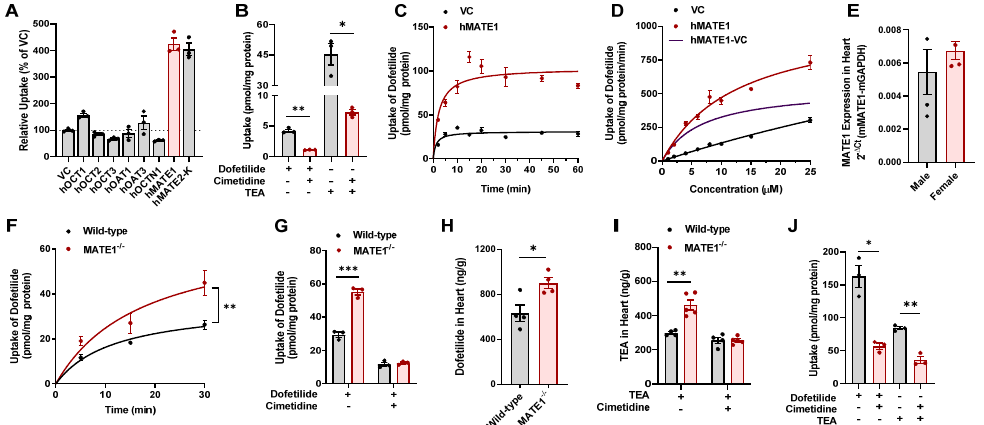
Figure 1. Inhibition of MATE1 enhances cardiac accumulation of dofetilide. ( A ) Transport of [ 3 H] dofetilide (1 µ M, 15 min) in cells overexpressing the human transporters OCT1, OCT2, OCT3, OAT1, OAT3, OCTN1, MATE1, or MATE2-K (2 min). Relative uptake is expressed as percentage change compared with empty vector controls (n = 3). ( B ) Relative uptake of [ 3 H] dofetilide and [ 14 C] TEA in HEK293 cells overexpressing human MATE1 in the presence and absence of cimetidine (25 µ M). ( C ) Time dependent uptake (2–60 min) of [ 3 H] dofetilide (1 µ M) in HEK293 cells stably transfected with vector control (VC) or MATE1. ( D ) Transport kinetics of [ 3 H] dofetilide in cells overexpressing human MATE1. The Michaelis-Menten constant (K m ) and the maximal uptake rate (V max ) values for the kinetics of dofetilide (1–25 µ M) was determined after an incubation time of 2 min. K m and V max values for transport activity are 6.72 ± 1.71 µ M, and 544.40 ± 55.70 pmol/min/mg, respectively. ( E ) Expression of the MATE1 gene in hearts isolated from untreated wild-type male and female mice (n = 4 per group). ( F ) Time dependent uptake of [ 3 H] dofetilide (2 µ M) in ex vivo cardiomyocytes isolated from wild-type or MATE1-deficient female mice (n = 4–6 per group). ( G ) Ex vivo concentrations of [ 3 H] dofetilide (2 µ M) in cardiomyocytes isolated from wild-type or MATE1-deficient female mice (n = 3 per group) for 30 min in the presence or absence of cimetidine (25 µ M) pretreatment. ( H ) Concentration of dofetilide in whole heart tissue from wild-type or MATE1-deficient male mice 15 min after a single i.v. injection of dofetilide via the caudal vein at a dose of 2.5 mg/kg (n = 4 per group). ( I ) Concentration of TEA in whole heart tissue from wild-type and MATE1-deficient male mice (n = 4–5 per group) with or without treatment of with cimetidine (100 mg/kg) 30 min before an i.v. administration of [ 14 C] TEA (0.2 mg/kg). Heart samples were collected 15 min after TEA administration. ( J ) Uptake of 2 µ M [ 3 H] dofetilide and [ 14 C] TEA in AC16 human cardiomyocytes (n = 3) for 20 min in the presence or absence of cimetidine (25 µ M) pretreatment (15 min). All experimental values are presented as mean ± SEM. Statistical analysis was performed using an unpaired two-sided Student’s t -test with Welch’s correction: * p < 0.05, ** p < 0.01, *** p <